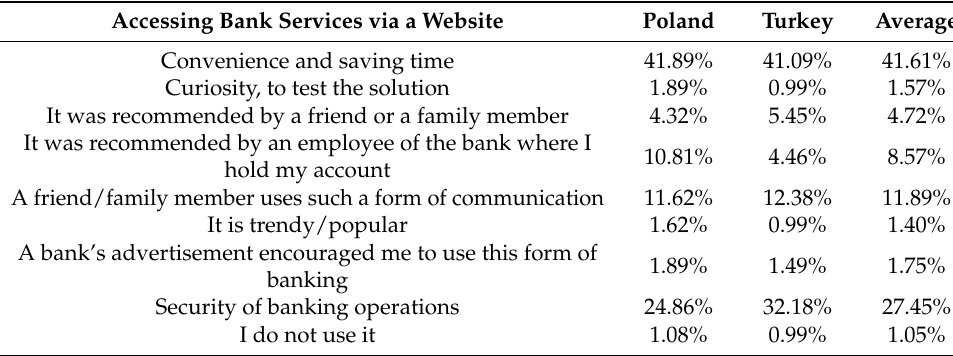
Table 3. Reasons for using a website to contact the bank; source: own work. Accessing Bank Services via a